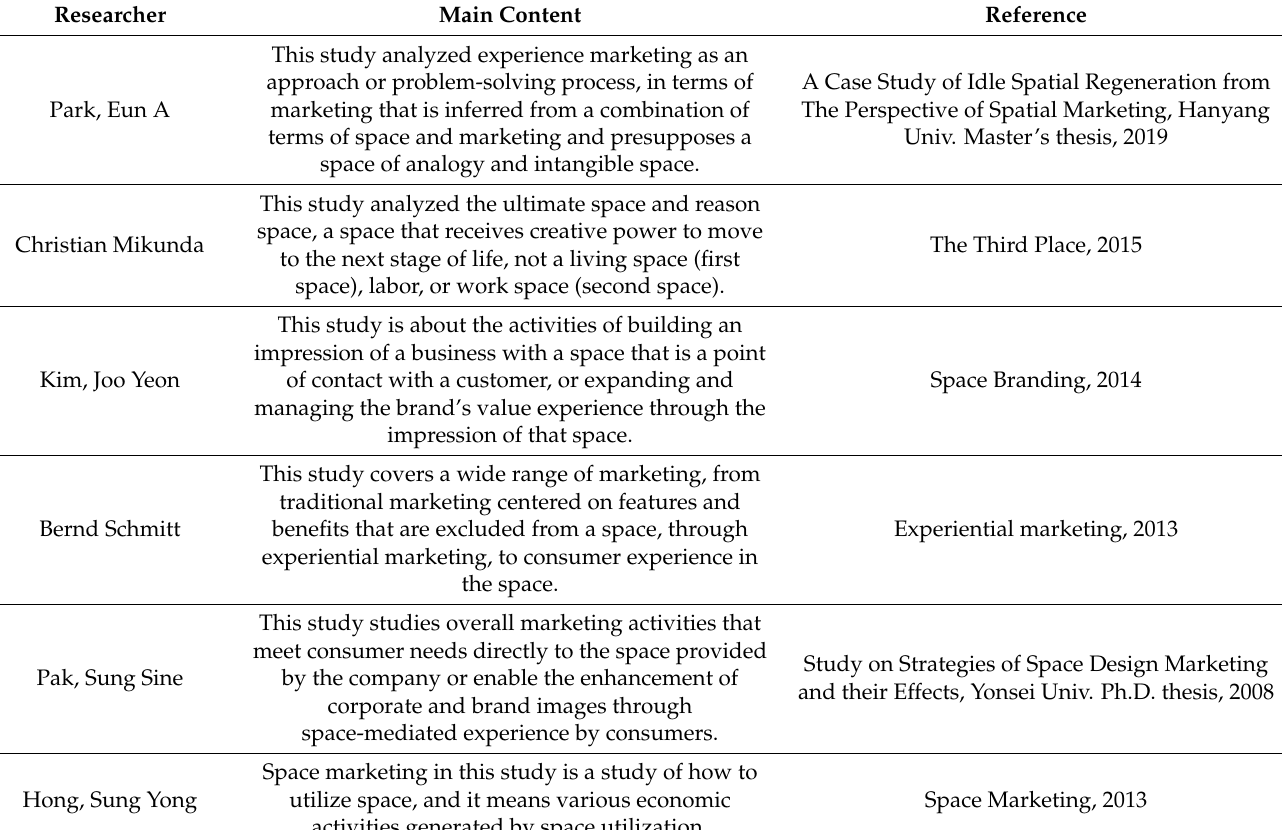
Table 1. Status of prior research related to spatial design